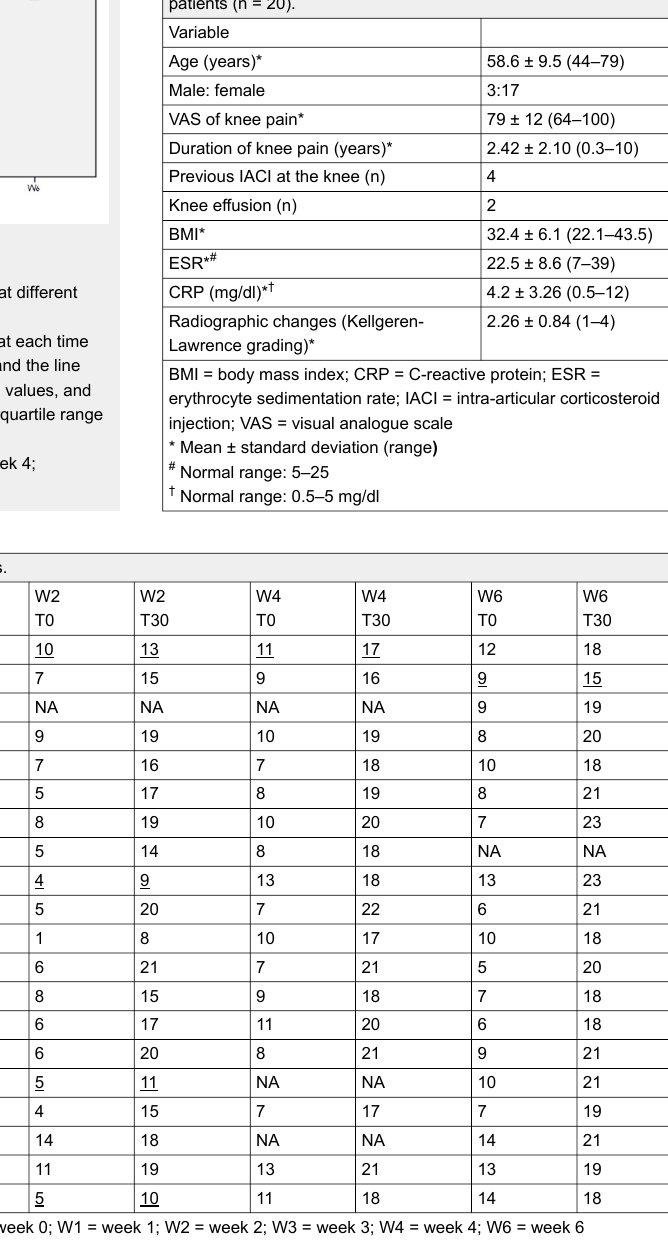
Table 1: Demographic, clinical and laboratory variables of the patients (n = 20).